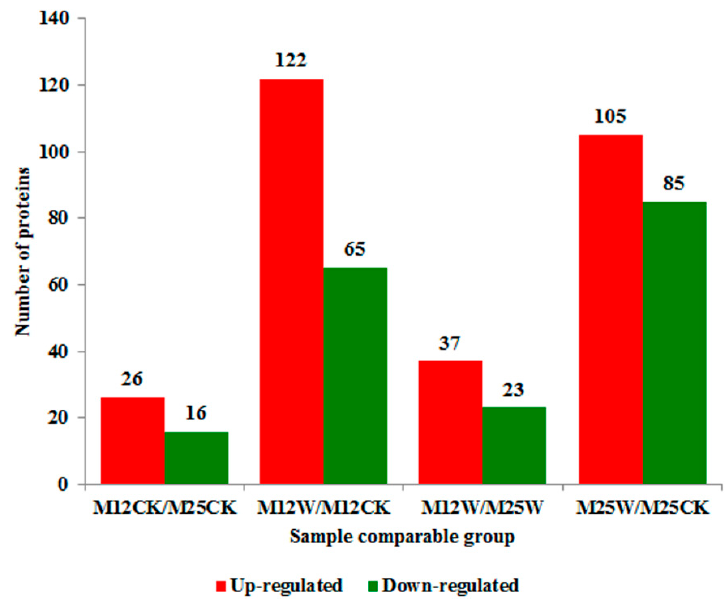
Figure 5. The number of differentially abundant proteins (fold change ≥ 1.3 or fold change ≤ 0.77 and p -value < 0.05) in two alfalfa cultivars (M12 and M25) under waterlogged and control conditions. M12CK indicate M12 under control condition; M12W indicate M12 under waterlogged condition; M25CK indicate M25 under control condition; M25W indicate M25 under waterlogged condition.